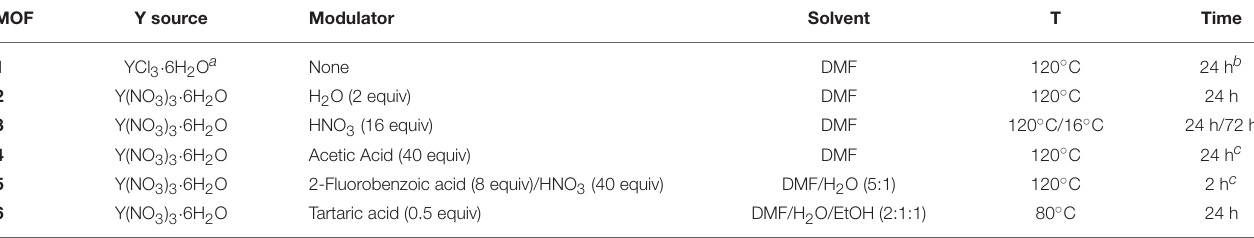
TABLE 1 | Summary of synthetic conditions used to prepare single crystals of Y-NDC MOFs 1 – 6 . MOF Y source Modulator